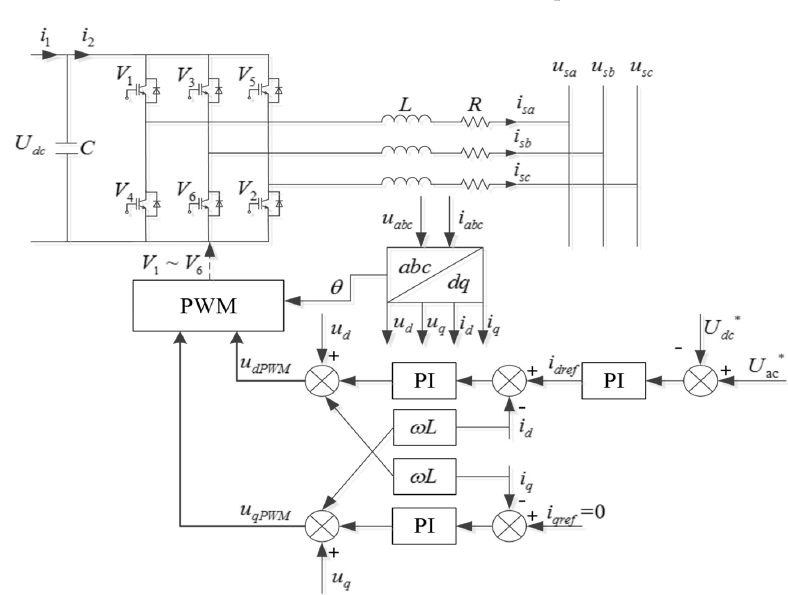
Figure 4. Control strategy of the ILC.